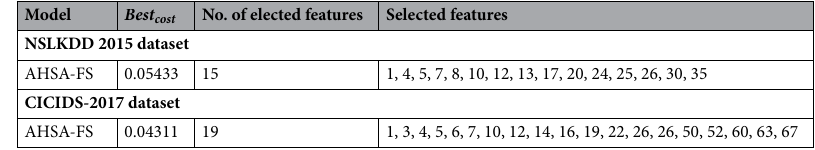
Table 1. FS Result Analysis of AHSA